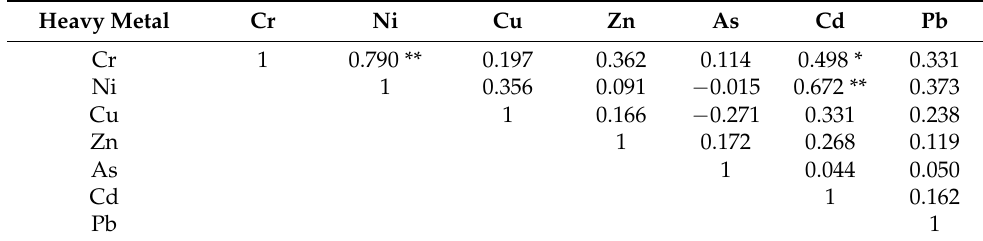
Table 8. Correlation analysis of heavy metal contents in ginger.